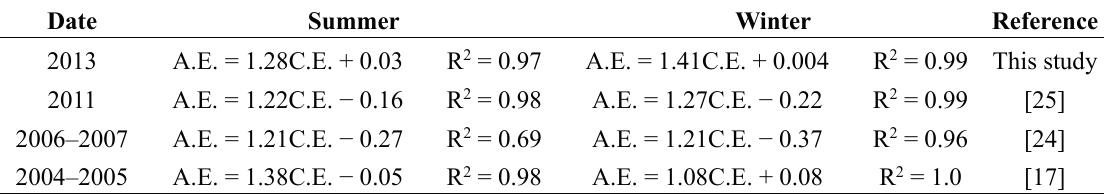
Table 3. Cation and anion balance in indoor PM 2.5 samples collected during several seasonal sampling campaigns from 2004 to 2013 [17,24,25].